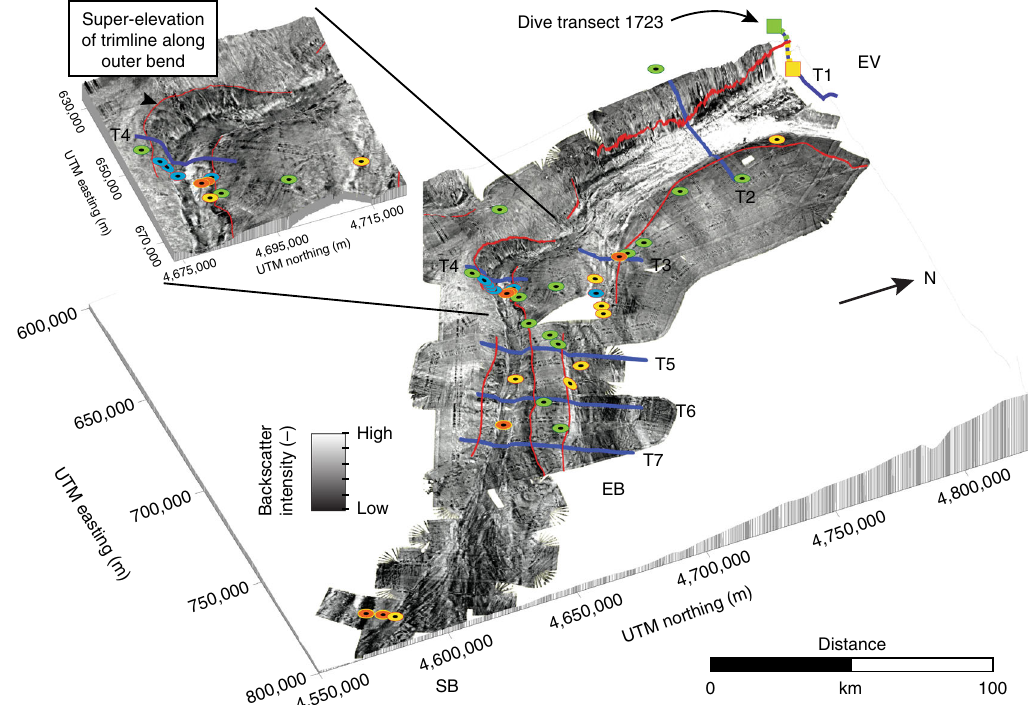
Fig. 2 Acoustic backscatter from Cruise MSM47 (see 'Methods') across the lower parts of the Eastern Valley channel system with interpretation of erosional trimlines from the 1929 fl ow. The Eastern Valley (EV) splits into two smaller channels: East Branch (EB) and South Branch (SB). High-intensity backscatter represents rough sandy deposits whilst low-intensity represents smooth mud. Erosional trimlines are inferred from sharp boundaries in backscatter intensity running along the margins of the channels (red lines). Cores show major erosion by the 1929 fl ow within the channels that extends up to the elevation of the trimlines (gravels — yellow, bypass drapes — blue and bounced — orange circles). Undisturbed sediments occur above the trimline (green circles). Dive transect 1723 (squares) shows fresh outcrop and bio-erosion (yellow line) sharply changing into undisturbed sediments (green line). Channel transects shown as blue lines (T1 – T7). The backscatter insert shows a more detailed picture of the super-elevated trimlines around the sharp